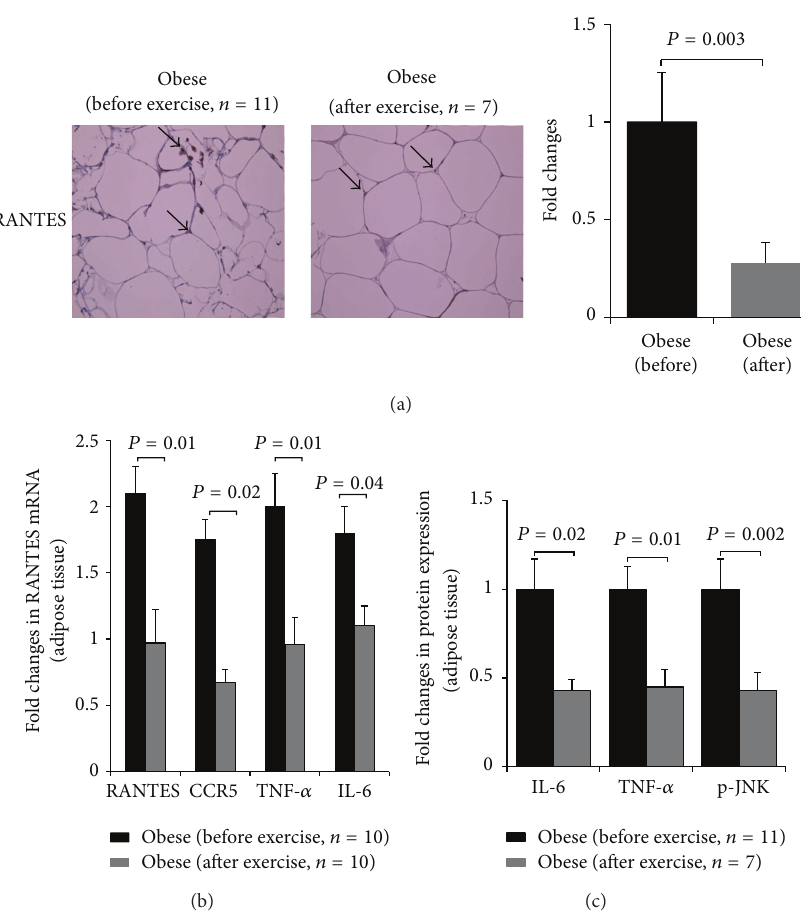
Figure4: Physical exercisereduces theexpression ofRANTESand CCR5intheadiposetissue. (a)IHCstainingwith RANTESantibody using subcutaneous adipose tissues from obese subjects before and after 3 months of physical exercise. Aperio software was used to quantify positive staining in obese before and after physical exercise. The data are plotted in a bar graph on the right of the figure as fold changes of RANTES protein expression in obese subjects before and after the physical exercise program. (b) qRT-PCR analysis of RANTES, CCR5, TNF- 𝛼 , and IL-6 mRNA expression in the adipose tissue from obese before and after 3 months of physical exercise. (c) Graphic representation of IHC staining with TNF- 𝛼 , anti-IL-6, and anti-Phospho-JNK antibodies using subcutaneous adipose tissues from obese subjects before and after 3 months of physical exercise. Aperio software was used to quantify positive staining in obese before and after physical exercise. Paired t -test for two group analysis was done to compare the expression of proteins and mRNA in obese before and after exercise. For each experiment, the sample size from each group is indicated by 𝑛